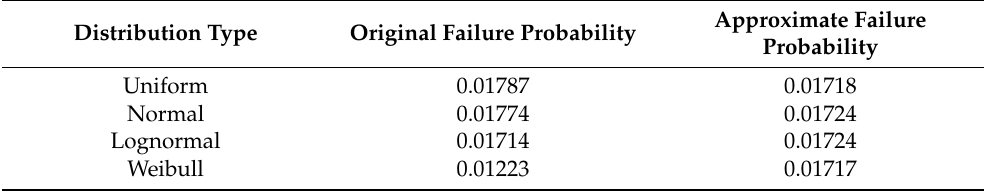
Table 6. Comparison of different distribution types.